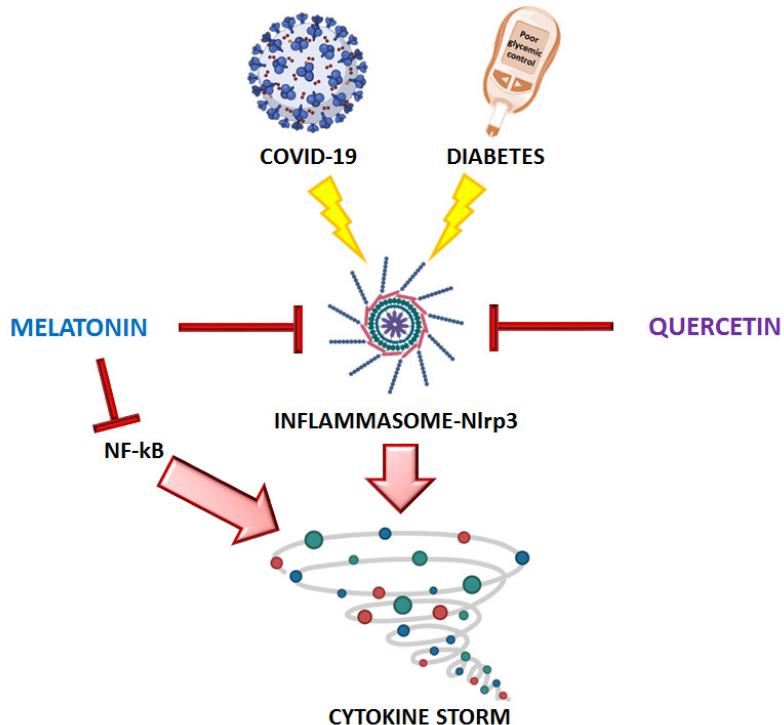
Figure 2. Proposed protective effects for melatonin and quercetin against SARS-CoV-2 infection. Melatonin and quercetin may blunt the deleterious effects of SARS-CoV-2 by reducing activation of the cytokine storm. Created with BioRender.com.